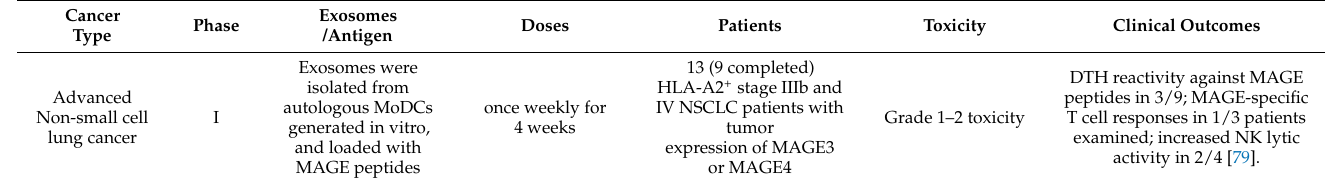
Table 1. Summary of current clinical trials with DC-derived exosomes